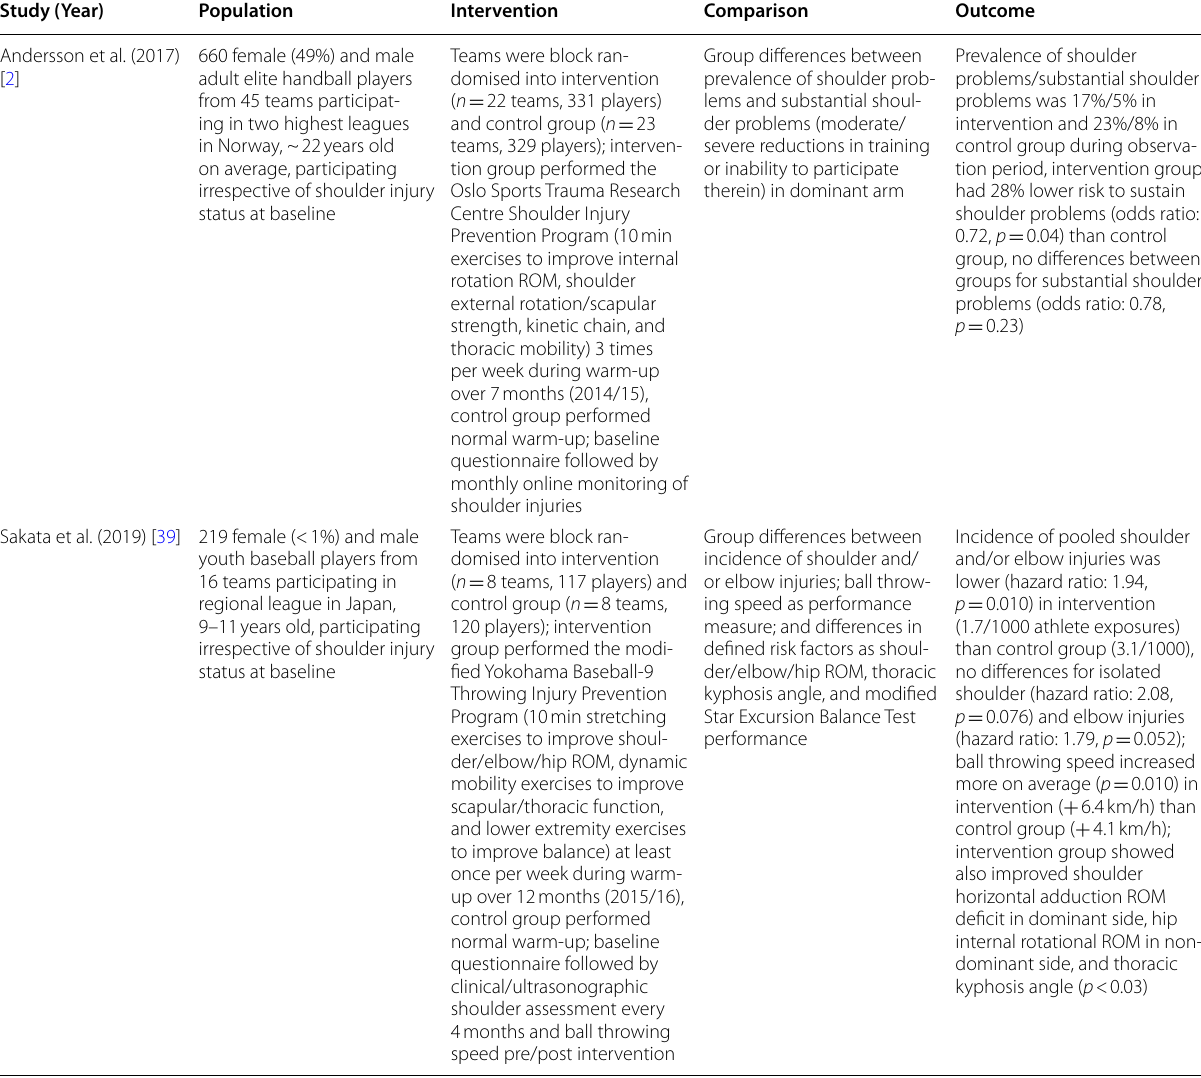
n Number of participants, ROM Range of